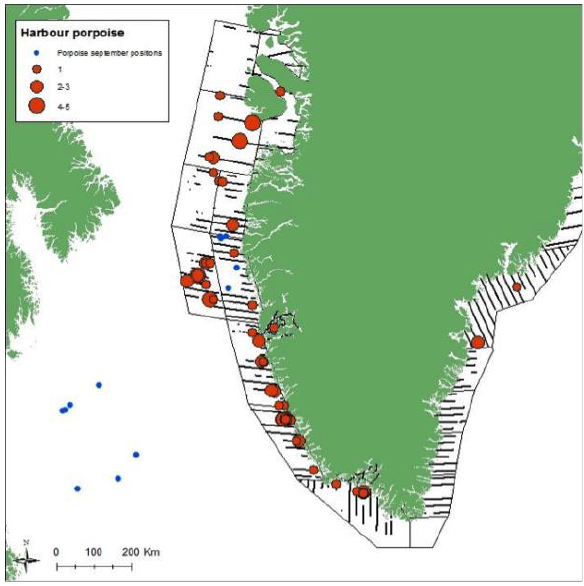
Figure 9. Survey effort in sea states <3 and sightings with group sizes of harbour porpoises in East and West Greenland. Blue dots indicate satellite positions of harbour porpoises tagged inside the survey area and tracked in September 2015.